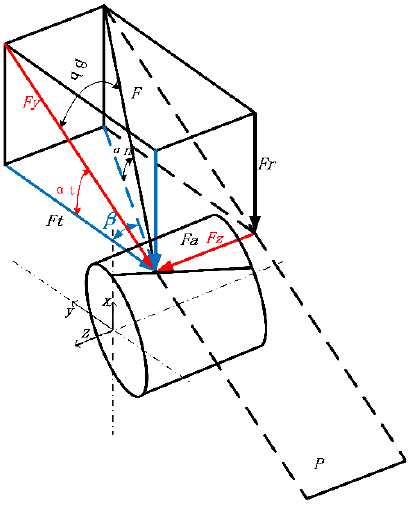
Figure 1. The force analysis diagram of helical gear.